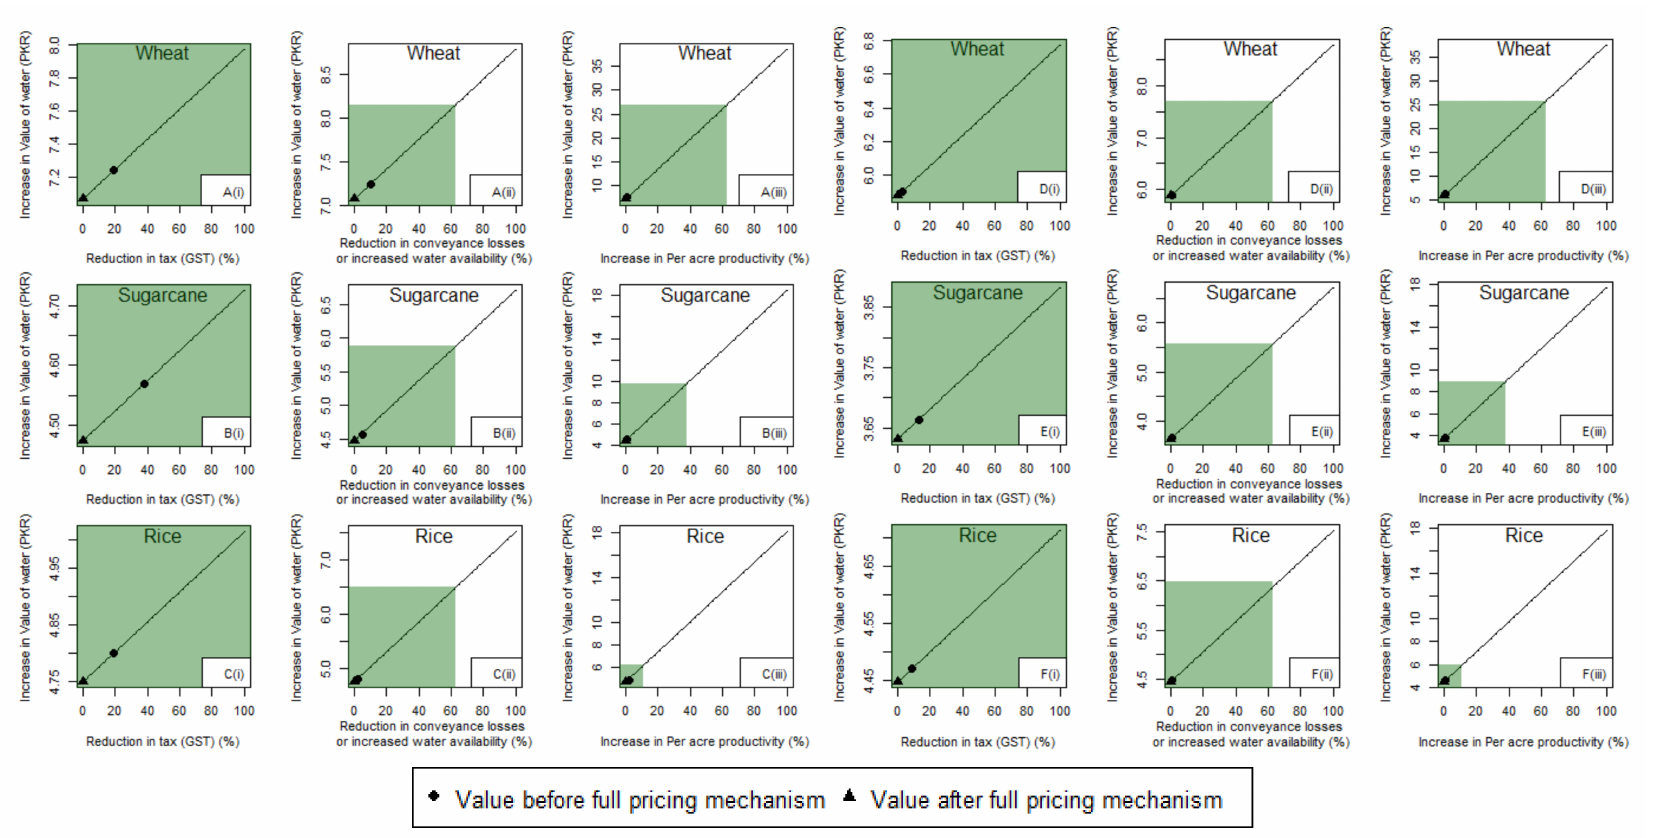
Figure 10. Response of water value for three crops against tax evasion, increased canal water availability and increased per hectare productivity for Gulliana, Khair-ali, Gatti ( A – C ) and Ratti distributaries ( D – F